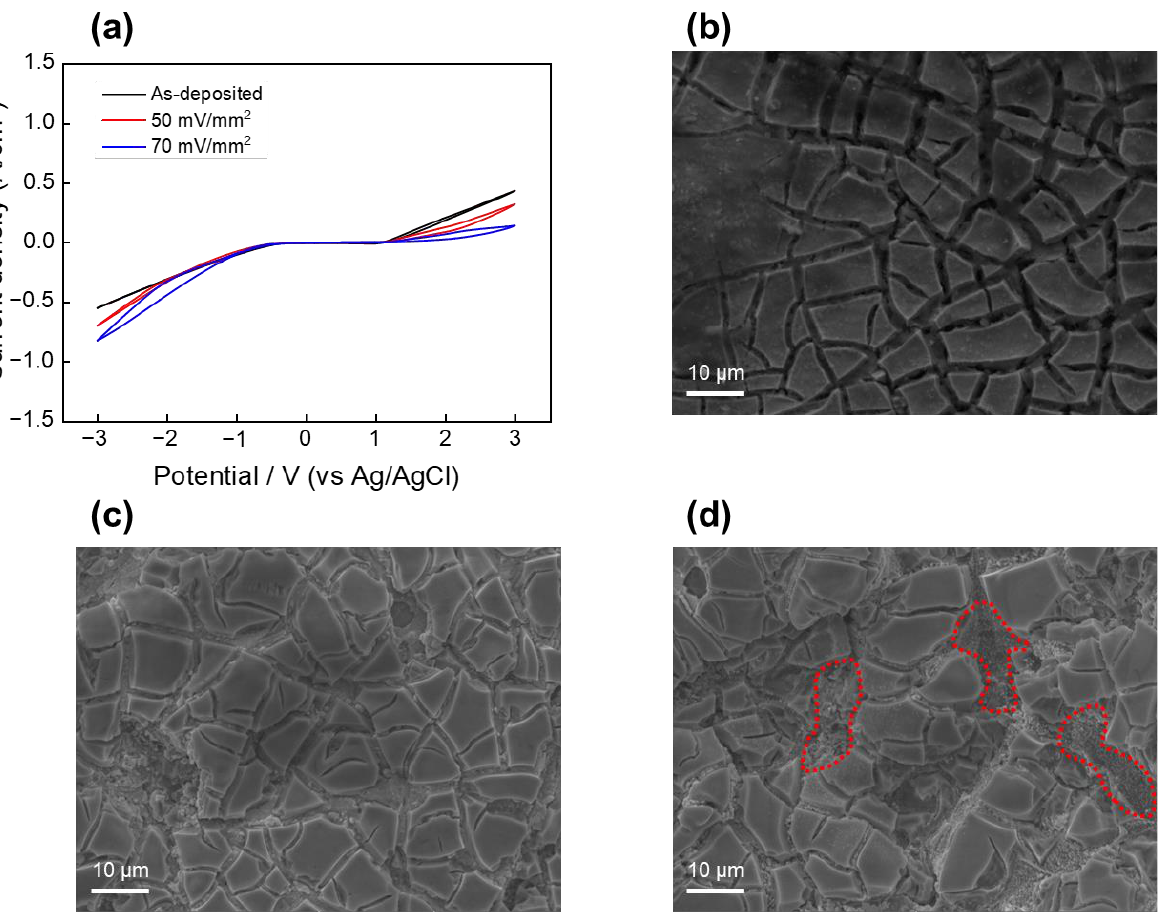
Figure 5. ( a ) Cyclic voltammetry curves and surface images ( b ) of as-deposited IrO 2 , after ED process at ( c ) 50 and ( d ) 70 mV/mm 2 . High-voltage processing does not show significant difference in potential window but causes delamination at 70 mV/mm 2 (ED processing time: 140 s, SSC thickness: 1 mm).